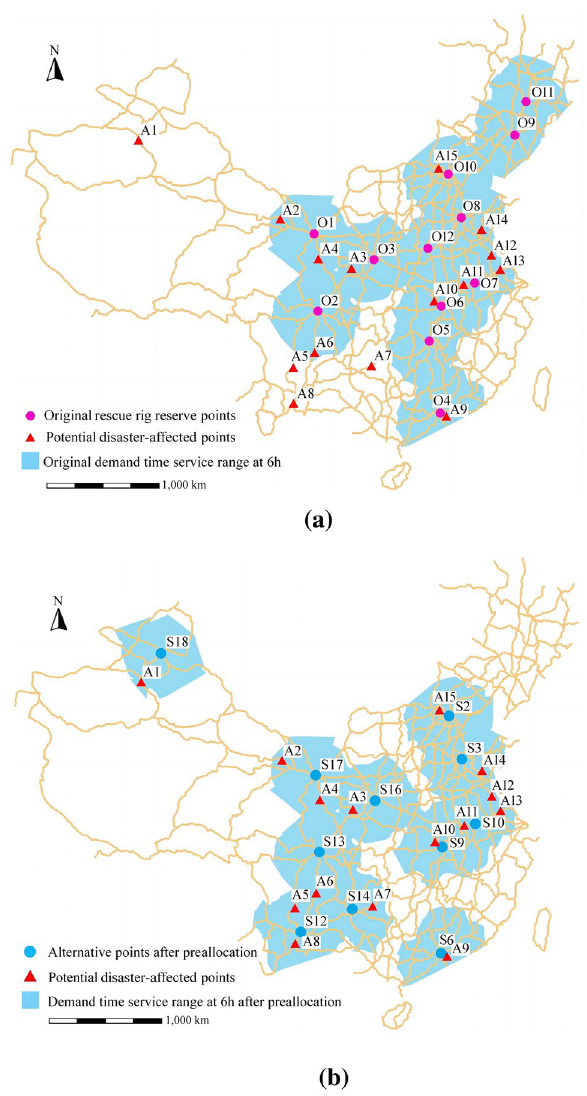
Fig. 5 The 6 hours demand time service range coverage of not preal- located cases ( a ); and the 6 hour demand time service range coverage of preallocated cases ( b )